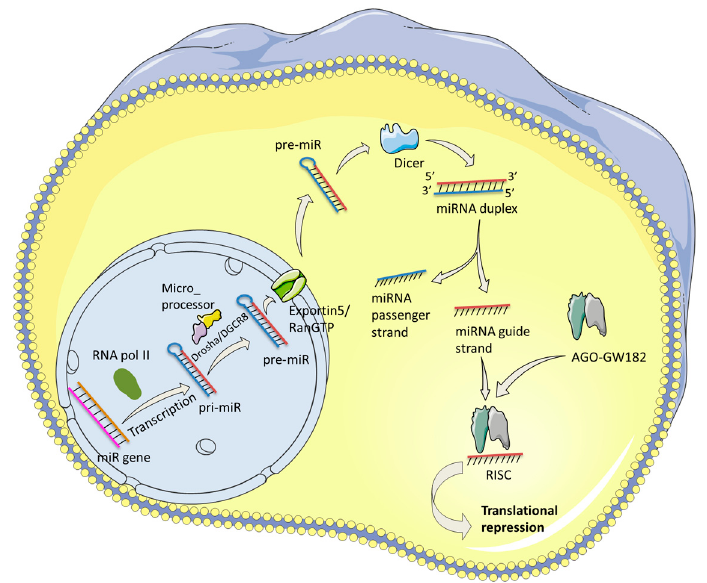
Figure 1. miRNA biogenesis. miRNAs are transcribed from miRNA genes by RNA pol II into pri-miRNA and cleaved by the microprocessor. The resulting pre-miRNA is exported to the cytoplasm by the exportin 5/RanGTP complex. Once in the cytoplasm, the endoribonuclease Dicer cleaves the pre-miRNA into a miRNA duplex. The mature miRNA is loaded into the AGO/GW182 complex forming the RISC complex, which mediates the translational repression. RNA pol II: RNA polymerase II; pri-miR: primary miRNA; pre-miRNA: precursor miRNA; AGO: argonaute; RISC: RNA-induced silencing complex.